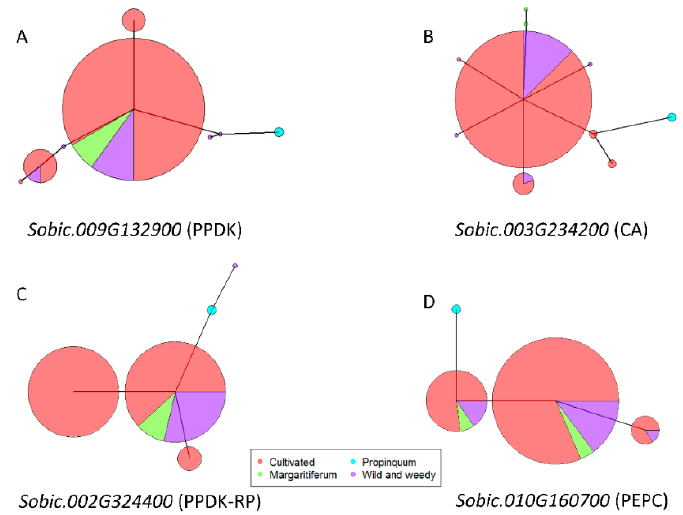
Figure 3. Haplotype network of 4 core C 4 gene with selection signal based on individual SNP analysis. ( A ) The PPDK gene (Sobic.009G132900) with signal of purifying selection; ( B ) one of the CA genes (Sobic.003G234200) with signal of purifying selection; ( C ) the PPDK-RP gene (Sobic.002G324400) with signal of balancing selection; ( D ) the PEPC gene (Sobic.010G160700) with signal of balancing selection. Group classification of sorghum accessions used as detailed in Table S1. Color-coding as follows; cultivated sorghum (red), wild and weedy genotypes (purple), Sorghum propinquum (blue), and Sorghum guinea margaritiferum (green). The size of the circles in the haplotype networks is proportionate to the number of accessions with that haplotype. The branch length represents the genetic distance between two haplotypes.